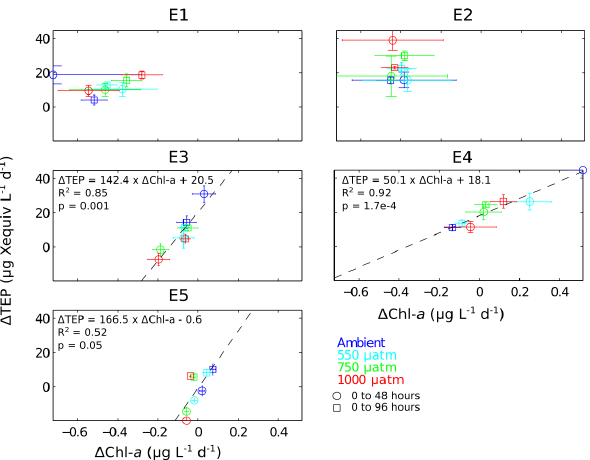
Figure 6. Relationship between transparent exopolymer particle production per day ( 1 TEP; µgXequivL − 1 d − 1 ) and total chloro- phyll a production per day ( 1 Chl a ; µGL − 1 d − 1 ) for five bioas- say experiments. The dashed line in E3, E4 and E5 is the result of a linear regression between these two variables and details of this analysis are also shown: regression equation, correlation ( R 2 ) and p value. Regression analyses for E1 and E2 were not statistically